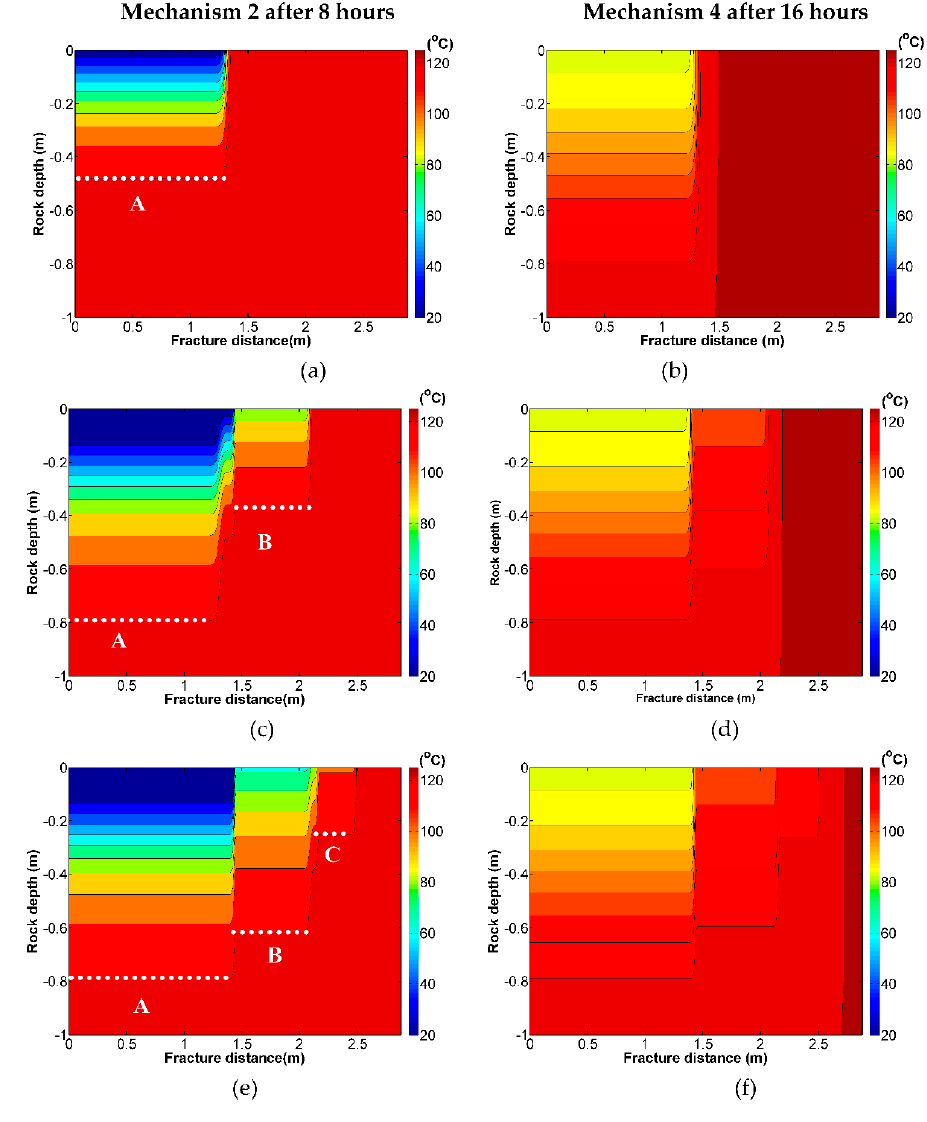
Figure 17. Cont. Figure 17.